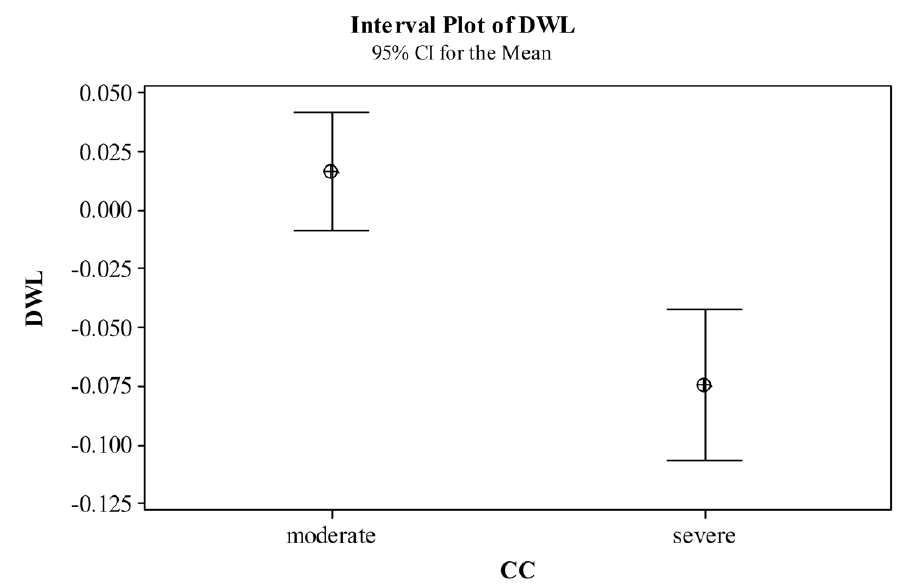
Figure 3. Interval plot of WL difference values for the canal curvature (CC) factor.